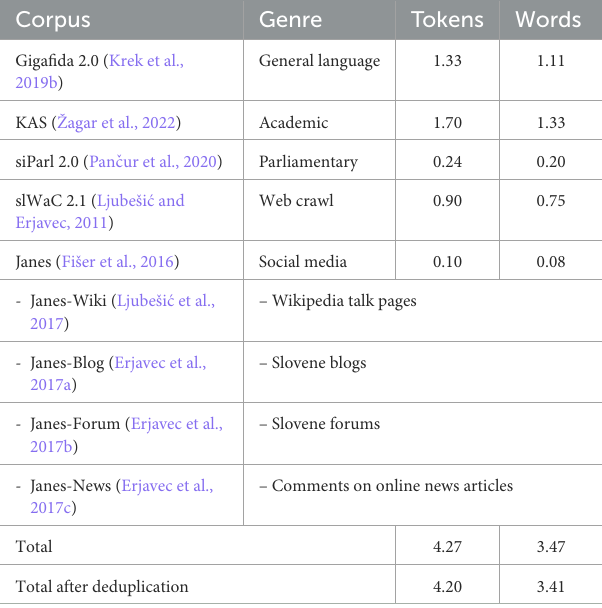
TABLE 1 Corpora used in training of SloT5 models with their sizes in billion of tokens and words. Corpus Genre Tokens